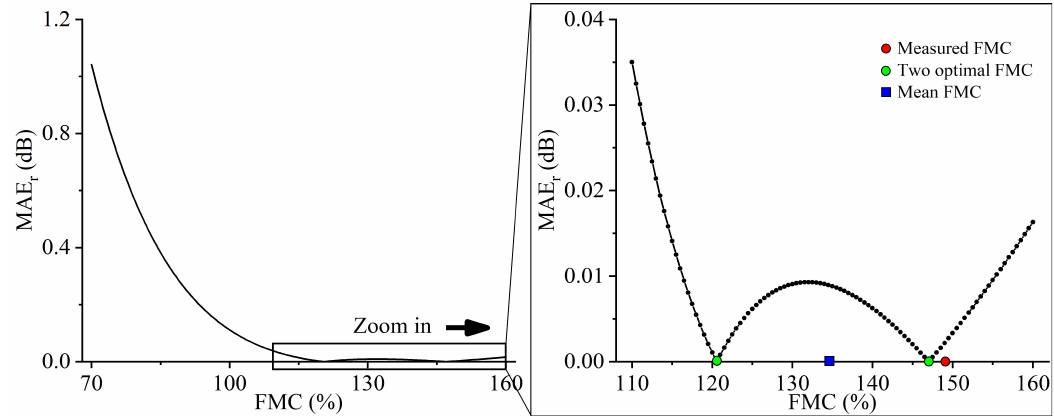
Figure 7. Illustration of the ill-posed inversion problem where two optimal FMC values (green points) can be obtained with the lowest MAEr.